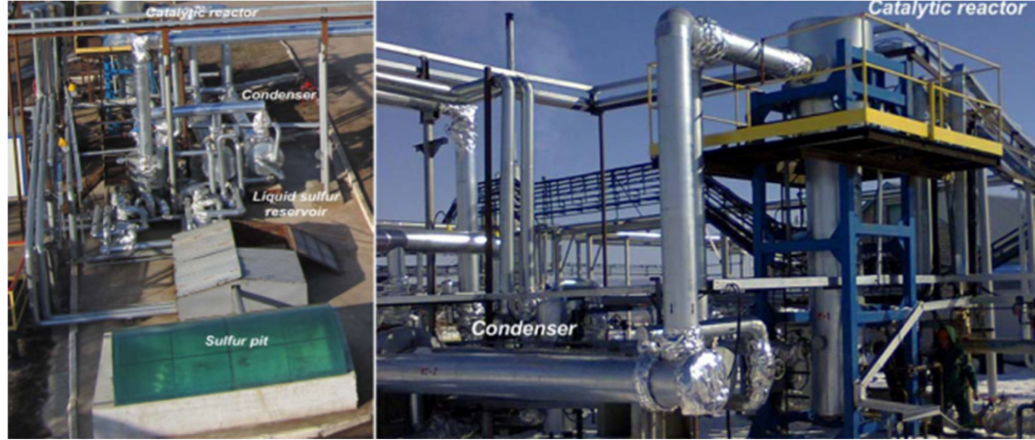
Figure 23. Industrial unit with a capacity of acid gas of up to 250 nm 3 /h, which has been in continuous operation since 2011. The hydrogen sulfide content is 30–65 vol.%.